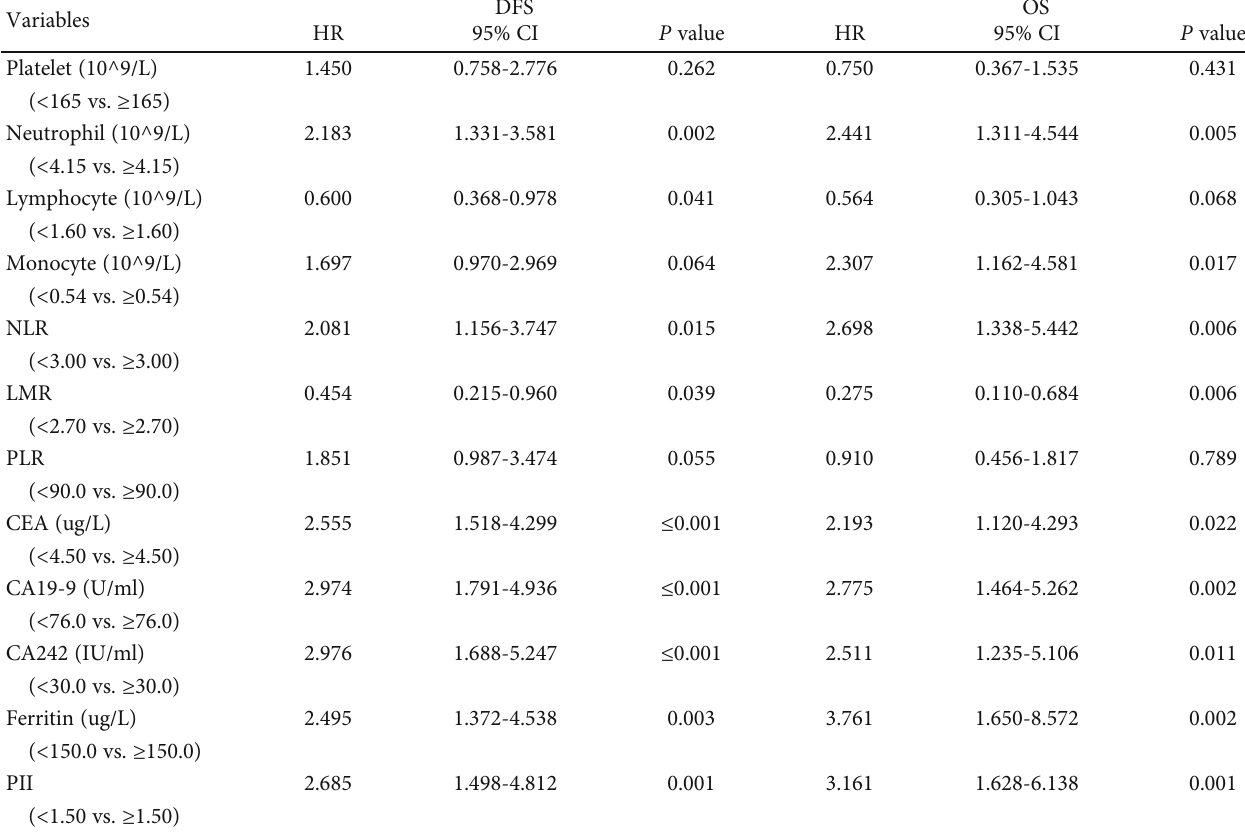
Table 1: Univariate analysis of prognostic factors for ICC in the training